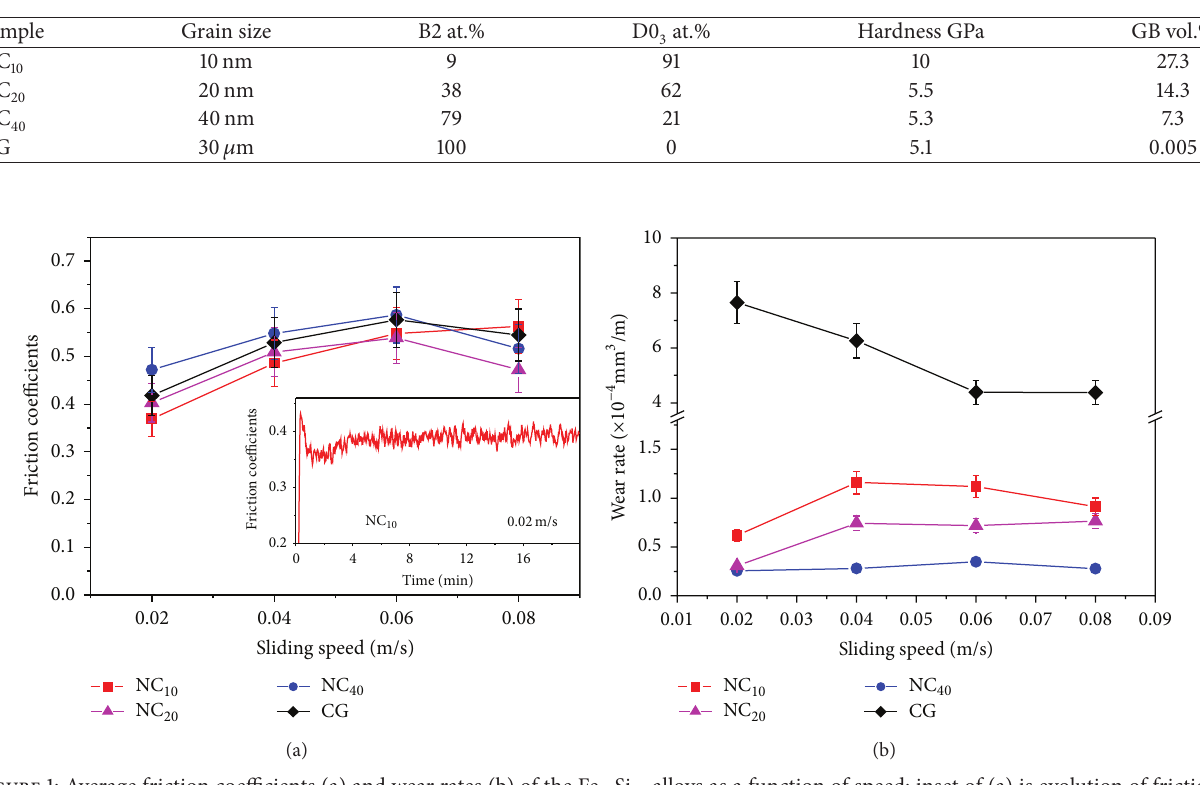
Table 1: Hardness and phase structures of the Fe